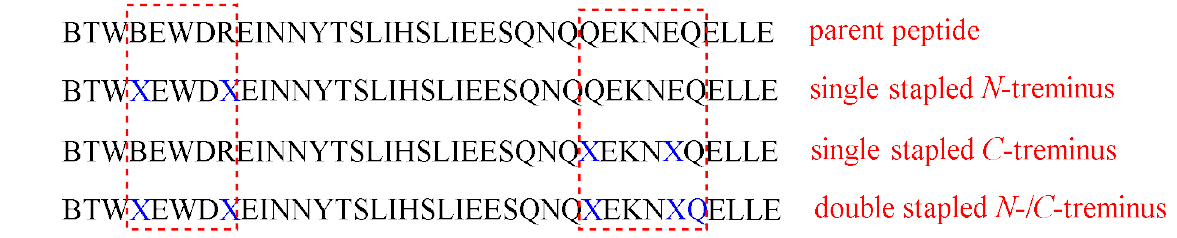
Figure 8. T649v parent peptides and the corresponding stapled modified analogs. X in blue represents the stapling positions.